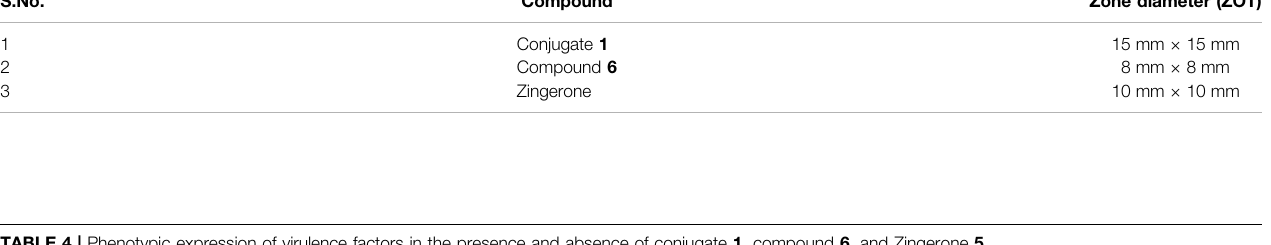
TABLE 4 | Phenotypic expression of virulence factors in the presence and absence of conjugate 1 , compound 6 , and Zingerone 5 . Compound Pyocyanin